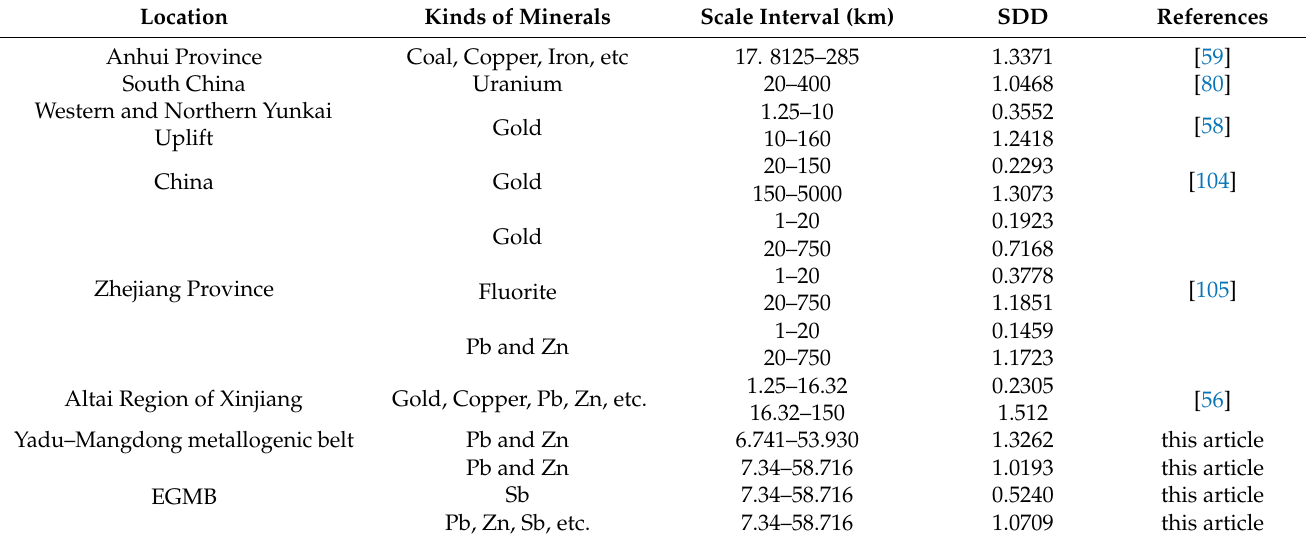
Figure 7. Linear fitting graph for spatial distribution fractal dimensions (SDD) calculation of ore deposits. Table 10. Statistical table of spatial distribution fractal dimensions (SDD) values of deposits in some areas of Table 9. Statistical table of calculation parameters for the spatial distribution fractal dimensions (SDD) of deposits.